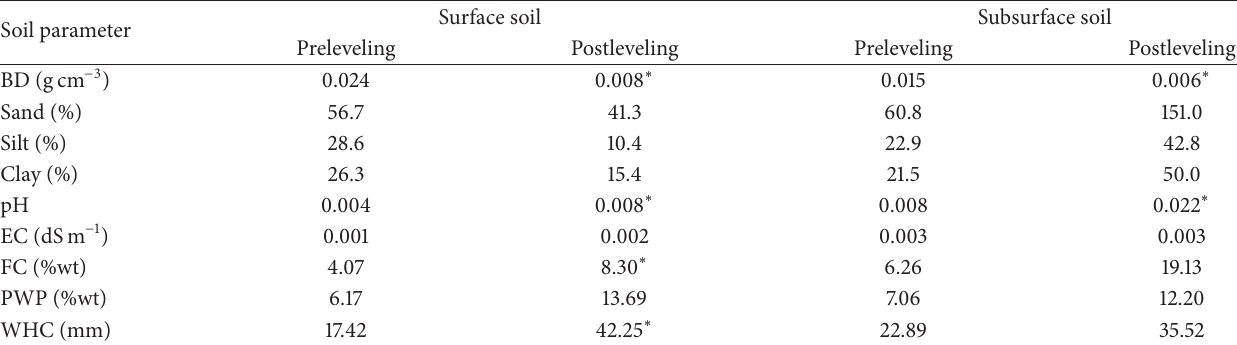
Table 2: The effects of land leveling on the sample variances of some selected soil properties from both 0–20 cm (surface soil) and 20– 40cm (subsurface soil). Asterisks next to postleveling variance values represent significant differences in the sample variances of pre- and postleveling soil properties caused by land leveling. The asterisks were obtained after employing Levene’s test ( 𝑛 = 30 ). Soil parameter